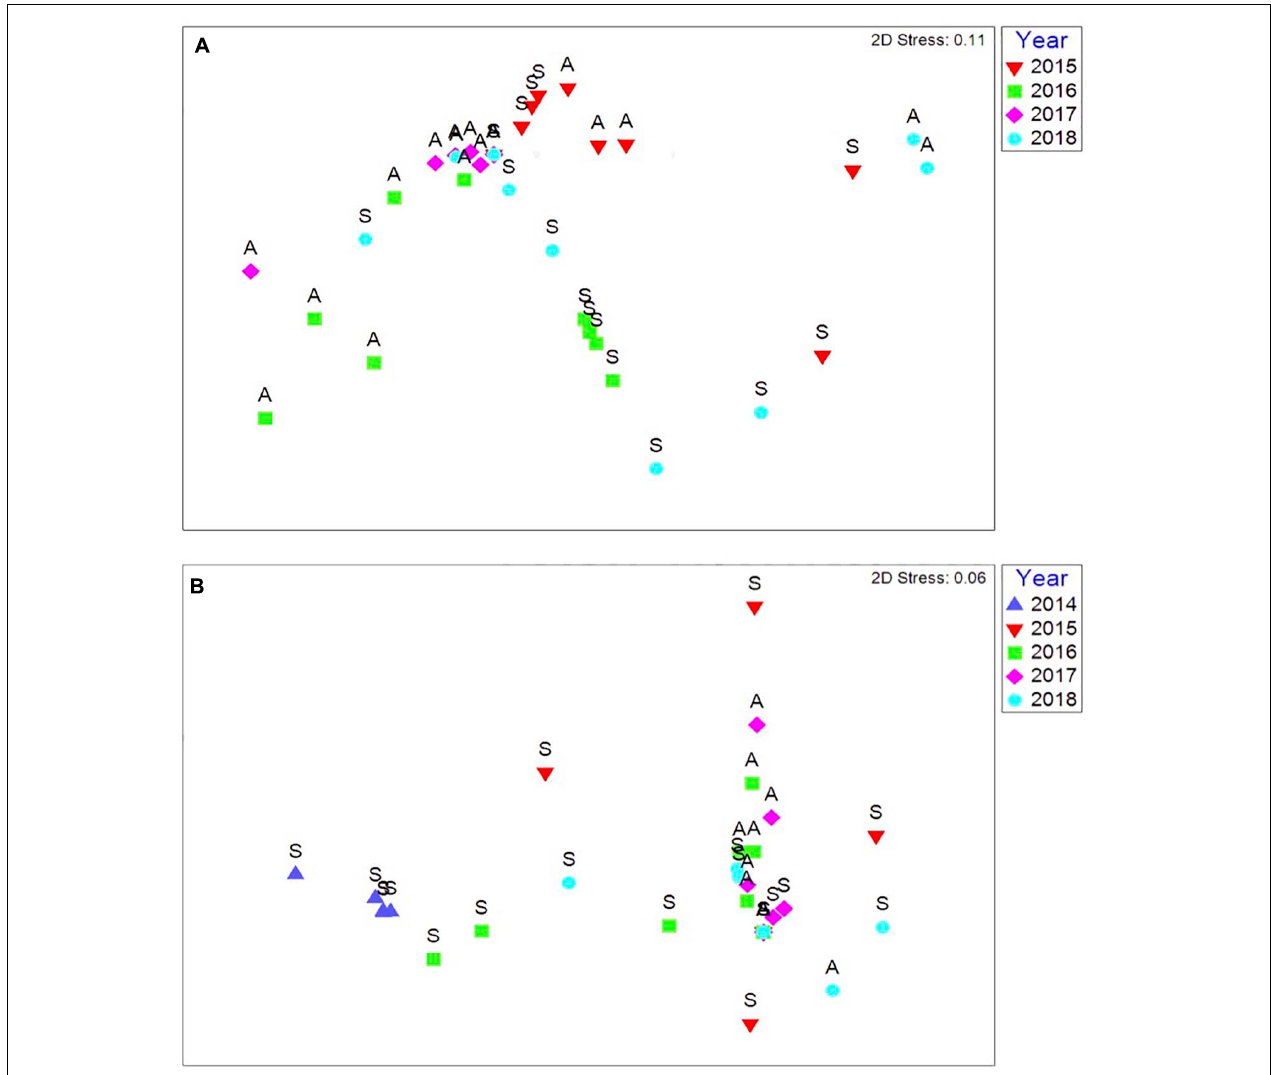
FIGURE 8 | (A) Multi-dimensional scaling ordination of communities diversity per season (S, Spring; A, Autumn) from immediately after the storm events in 2015 until autumn 2018 in the low eulittoral at Crackington Haven, (B) Multi-dimensional scaling ordination of communities diversity per season (S, Spring; A, Autumn) from immediately after the storm events in spring 2014 until autumn 2018 in the mid eulittoral at Crackington Haven. Based on Bray Curtis similarity coefficient, non-standardised data and square root transformed